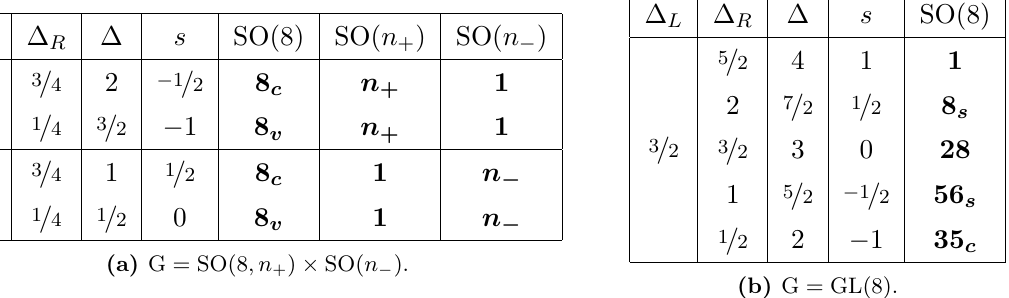
2 ; R ) solutions with (a) chiral and (b) diagonal embedding of j